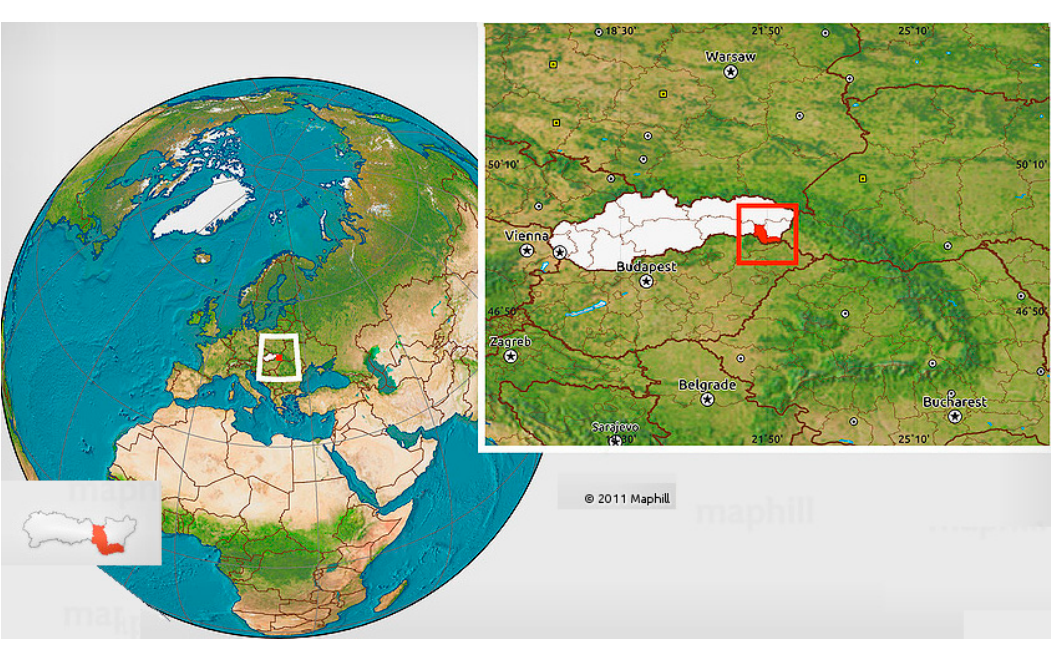
Figure 2. Location of Slovakia and Trebišov district within the European Union (adapted from maphill.com) [25].